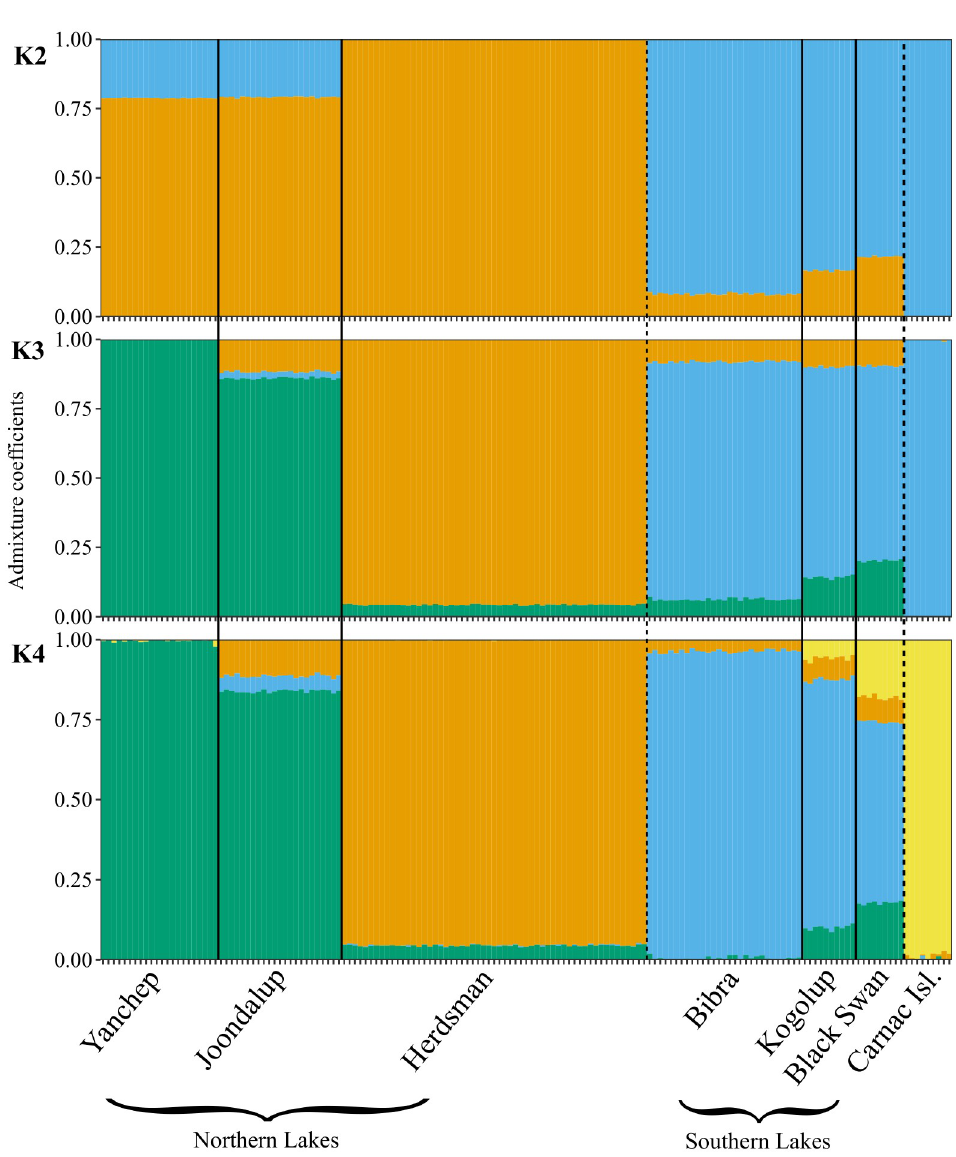
Fig 3. Admixture bar plot comparing population structure in Notechis scutatus occidentalis from Perth, Western Australia. Each tick mark on the x-axis represents an individual snake, which are grouped by sampling locations. The dashed line represents the biogeographic barrier of the Swan/Canning rivers separating the northern and southern sampling localities. The y-axis represents the fraction of individuals’ genome that originates from a particular ancestral population, each of which has been given a unique